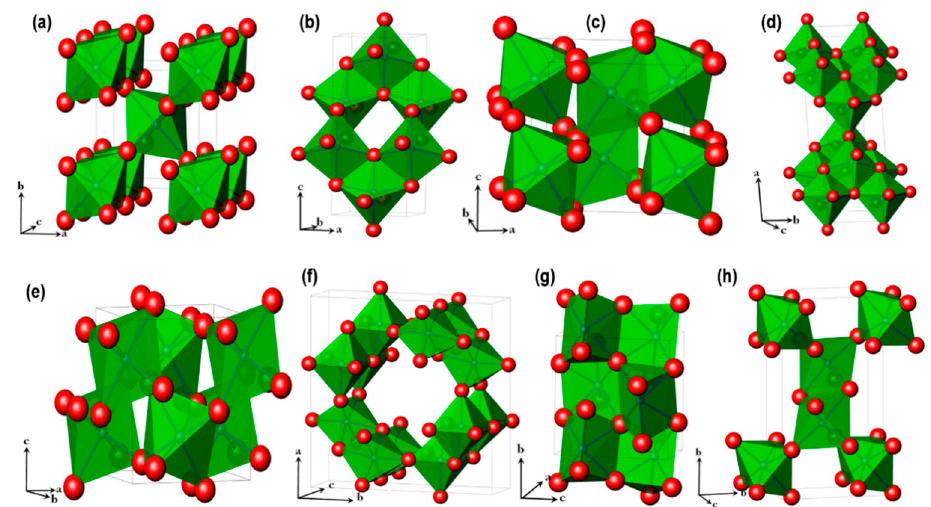
Figure 2. TiO 2 crystal structures of ( a ) rutile, ( b ) anatase, ( c ) bronze, ( d ) brookite, ( e ) columbite, ( f ) hollandite, ( g ) baddeleyite and ( h ) ramsdellite phases. Reprinted from ref. [111] with permission of Elsevier.